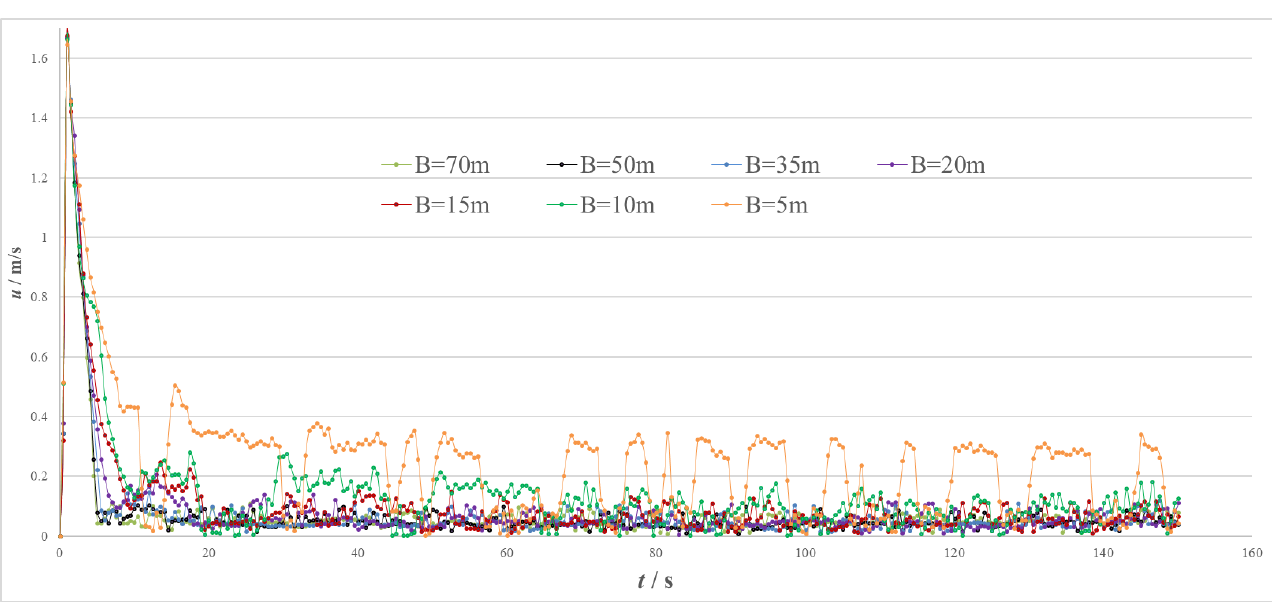
Figure 9. Plots of tracked velocity in the x -direction with different breach widths during dam breaking. In the governing equation (i.e., Equations (1) and (2a–e)) used to describe the granular motion, the flow of granules was mainly balanced by the flux vectors and the source terms.